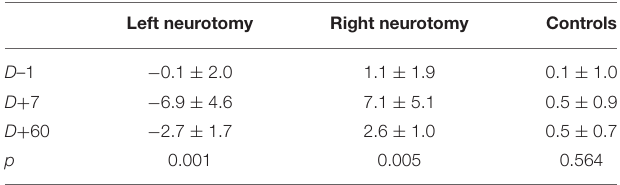
TABLE 3 | Subjective visual vertical data of patients and